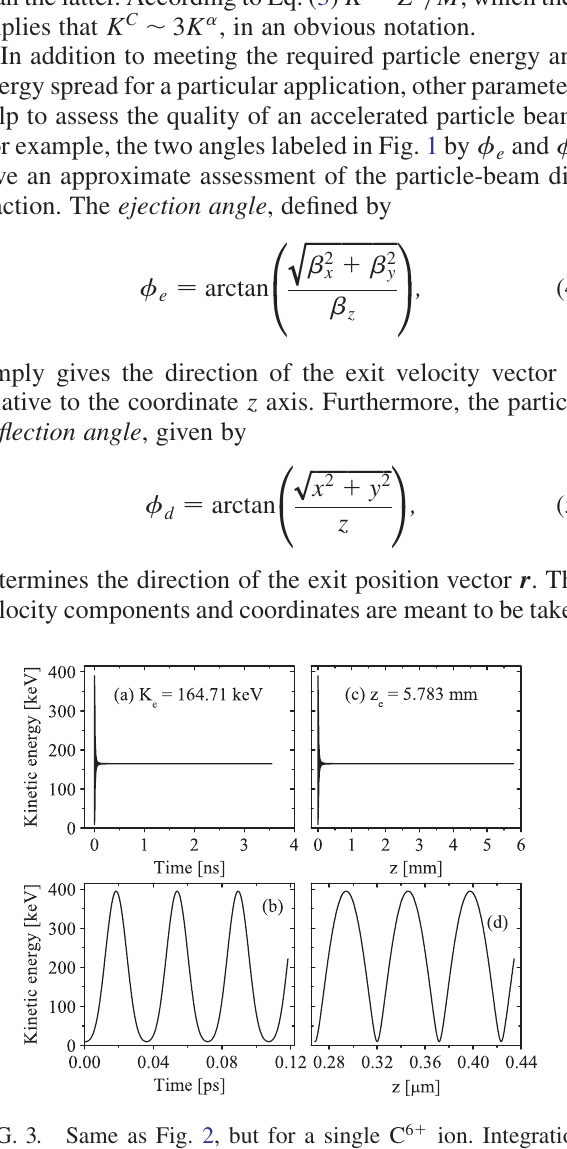
FIG. 5. Same as Fig. 4, but for C 6 þ ions. All other parameters are the same as in Fig. 3.